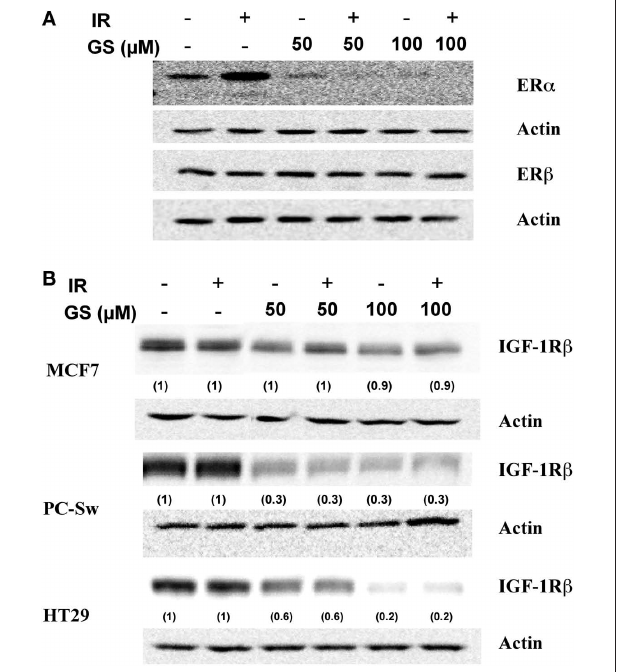
FiguRe 2 | The effect of gS and iR on eR α , eR β , and igF-1R β levels. (A) MCF7 cells were treated with either 50 or 100 μM GS for 24 h and probed for ER α and ER β changes. After treatment protein was isolated and processed for Western analysis to determine both ER α and ER β levels. Blots were stripped and re-probed with actin antibodies. (B) MCF7, HT29, and PC-Sw cells were treated with 50 or 100 μM GS for 24 h and probed for changes in the levels of IGF-1R β . After treatment protein was isolated and processed for Western analysis to determine IGF-1R β levels. Blots were stripped and re-probed with actin antibodies. Numbers in parenthesis represent normalized protein levels using actin as the loading